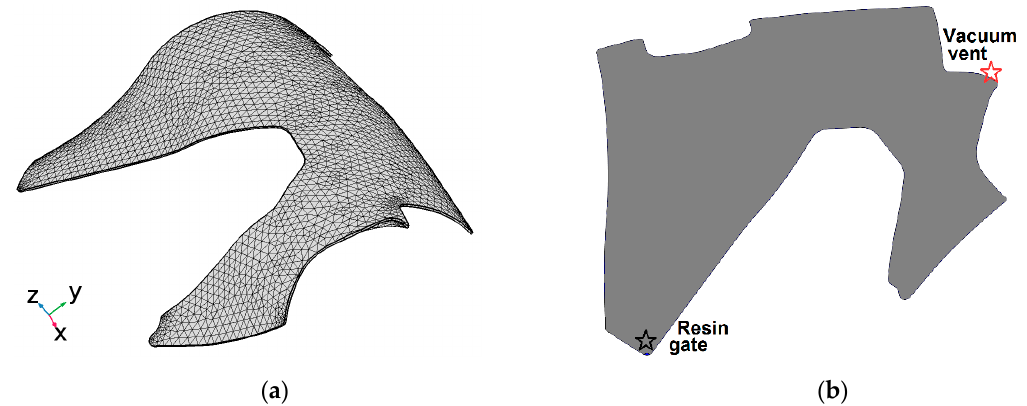
Figure 13. The finite element meshing of the infused part geometry ( a ); resin gate and vacuum vent location ( b